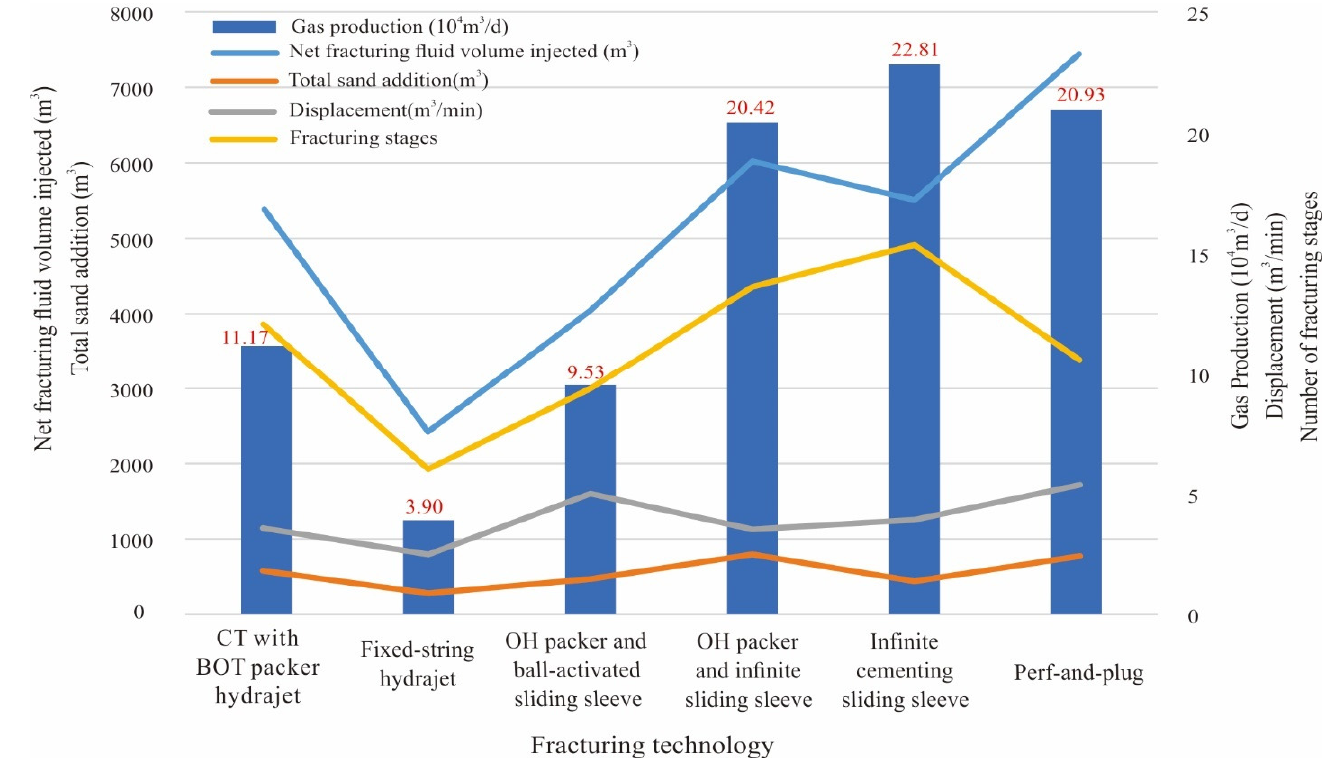
Figure 11. Well production and parameters according to multistage fracturing technologies.